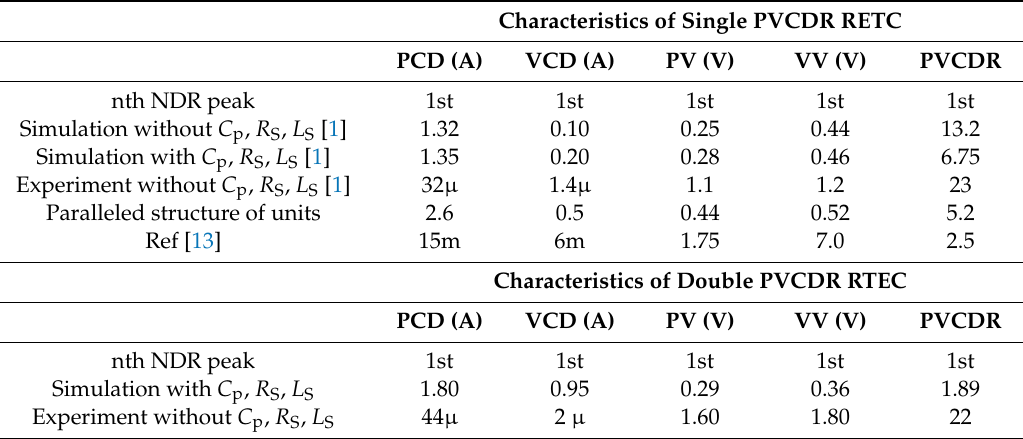
Table 1. Comparisons of PVCDR RTEC structures.